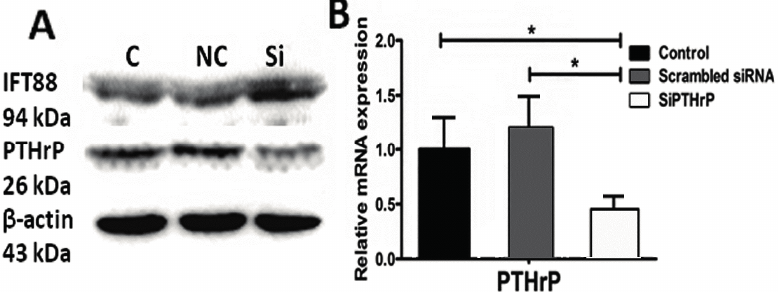
Figure 7. siRNA could decrease PTHrP expression in both protein and gene levels. The left image A shows the effect of siRNA on PTHrP and IFT88 proteins expression; The right one ( B ) display the interfere efficiency of siRNA on PTHrP in gene level. ( * p <